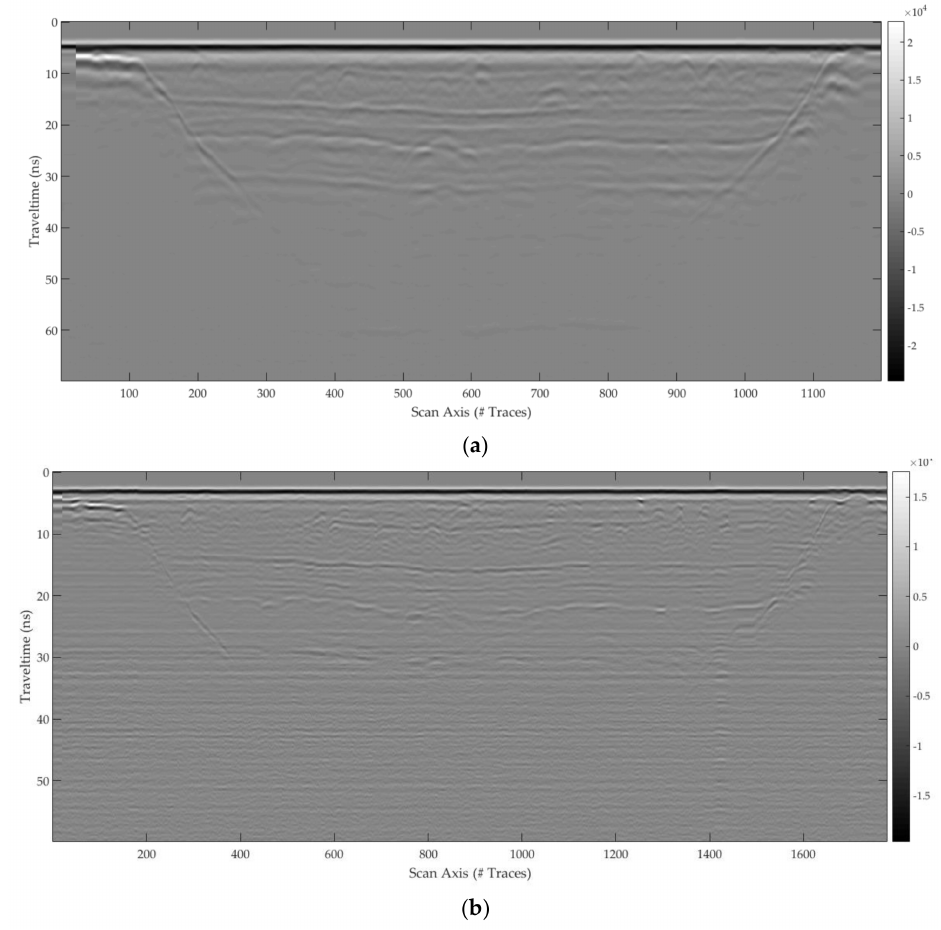
Figure 21. Profiles recorded in the multilayer by using GPR 1, with antennas operating at: ( a ) 400 MHz; ( b ) 900 MHz.